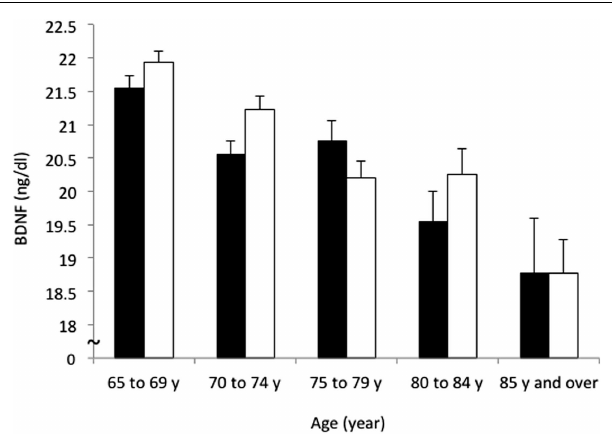
FIGURE 2 | Sex and age differences in serum BDNF concentration . Mean and standard error of serum BDNF levels are shown for each 5-year increment in age. Serum BDNF decreased with aging in men (black bars) and women (white bars; P < 0.001) and women showed higher BDNF levels than men ( P = 0.031).